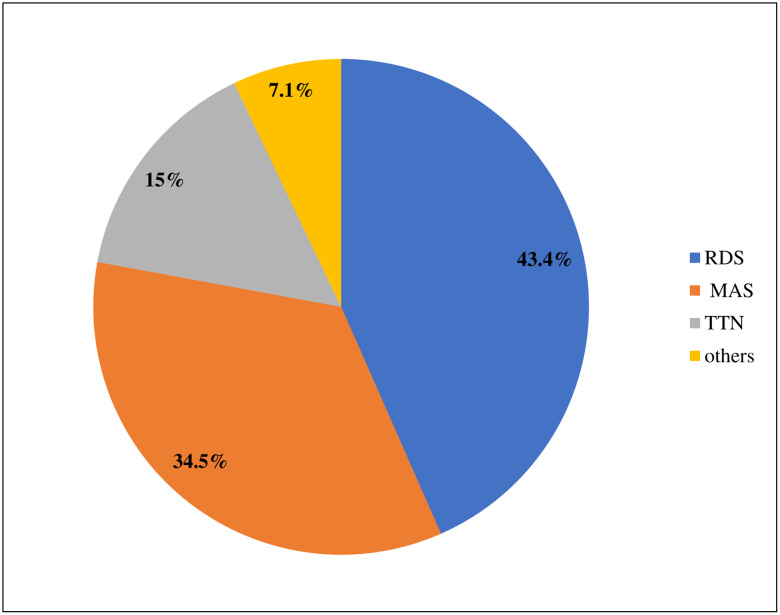
Common types of neonatal RD at Black Lion Specialized Hospital, Ethiopia.